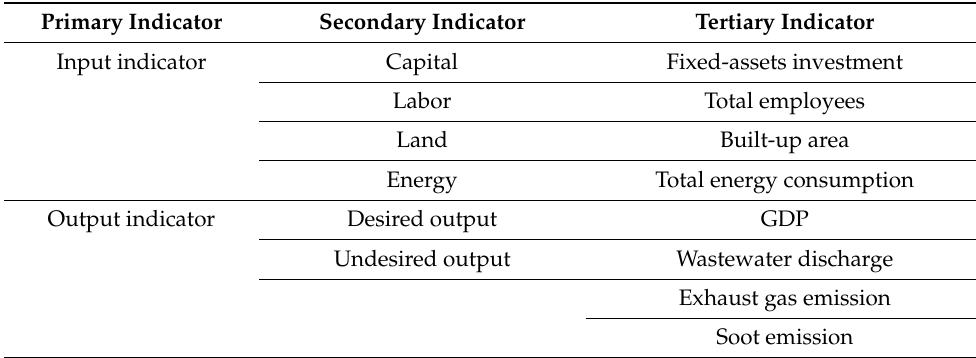
Table 2. Input and output indicators for calculating green land utilization efficiency. Primary